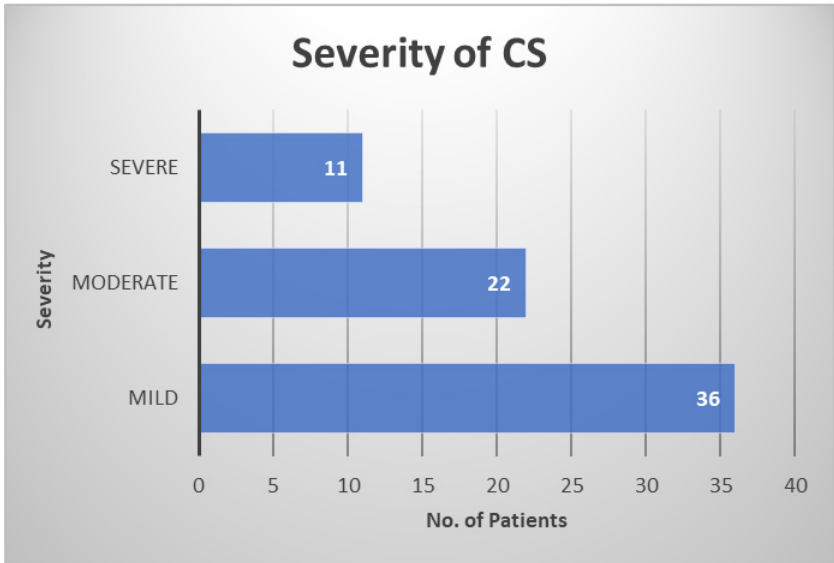
Figure 4. Distribution of patients affected by compensatory sweating (CS) according to